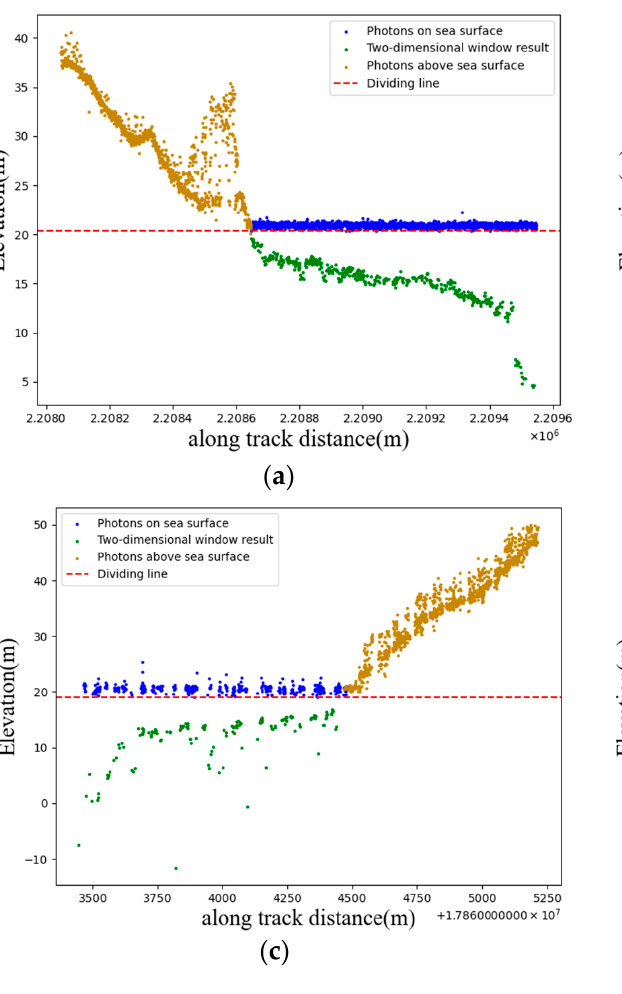
Figure 8. ( a ) Two-dimensional window fi lter denoised 480 orbit gt1r beam; ( b ) two-dimensional window fi lter denoised 480 orbit gt2r beam; ( c ) two-dimensional window fi lter denoised 1036 orbit gt2r beam; ( d ) two-dimensional window fi lter denoised 1036 orbit gt1r beam.